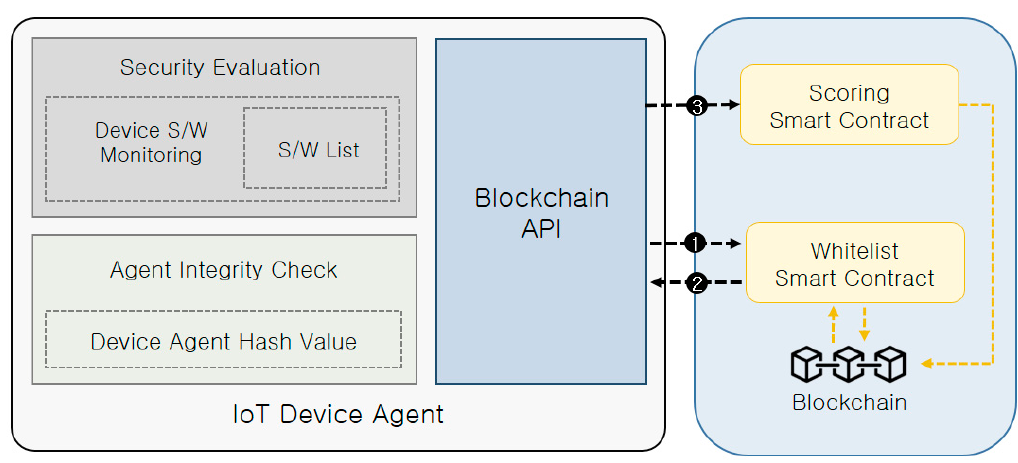
Figure 3. IoT device agent.